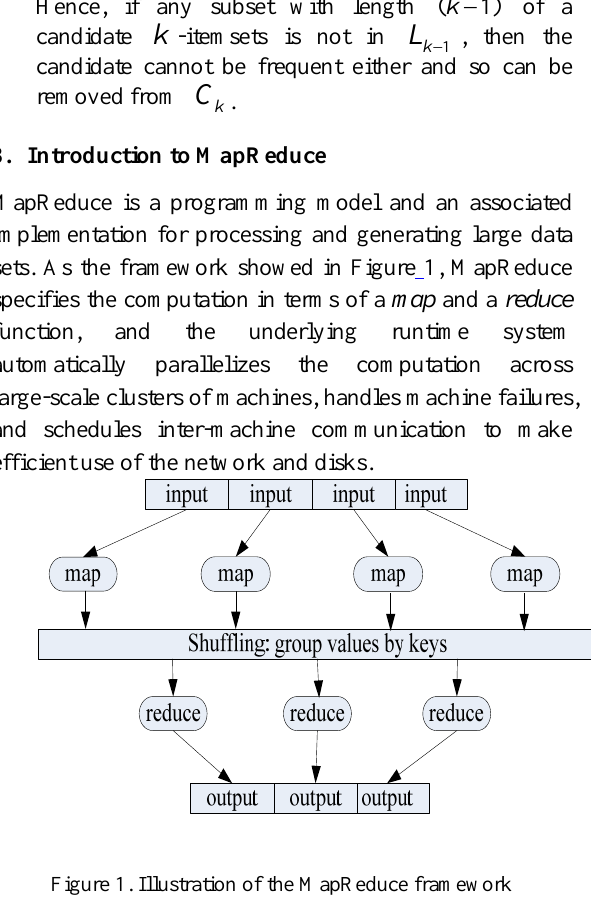
Figure 1. Illustration of the MapReduce framework Map takes an input pair and produces a set of intermediate key/value pairs. The MapReduce library groups together all intermediate values associated